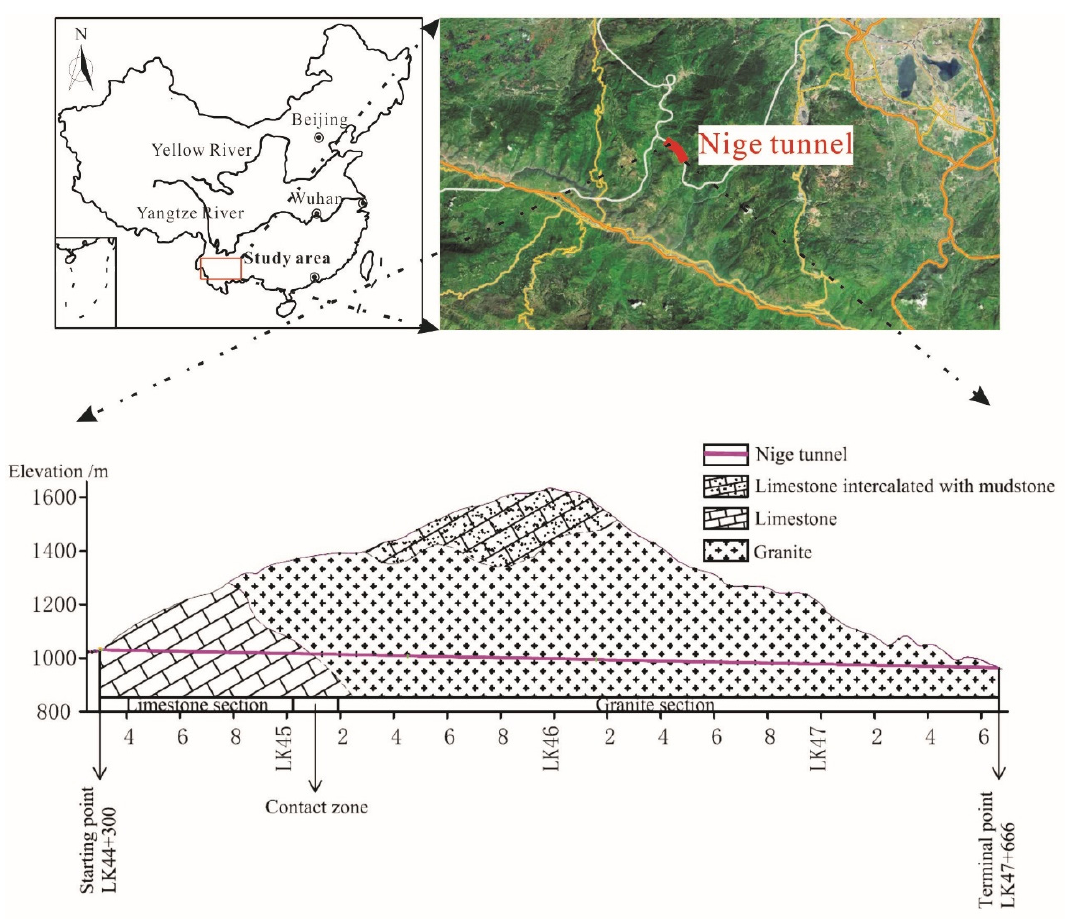
Figure 1. Geographical location and cross section of the Nige tunnel. The Nige tunnel crosses high and middle mountain terrain, with a distribution eleva- tion of 959 m to 1641.6 m, and the relative height difference is 682.6 m. The topographic slope at the tunnel entrance section is relatively steep, with a slope of 30 ◦ to 35 ◦ . The slope near the tunnel is distributed with Quaternary loose eluvial diluvium, on which the vegetation, mainly shrubs, is well developed, and the bedrock is locally outcropped. The topographic slope at the tunnel exit section is 20 ◦ to 25 ◦ . Simultaneously, the slope is also distributed with Quaternary loose eluvial diluvium, and the vegetation on it is densely developed. From the high elevation to the low elevation in Figure 1, the strata in the Nige tunnel site are Quaternary eluvial diluvium and Yanshanian granite, which is the lower member of the Gejiu formation of the Middle Triassic system. The lithology is a light gray thin layer and a medium-thick layer of dolomite and limestone. Since the Paleozoic, the tunnel site has experienced many tectonic disturbances, so a complex geological structure occurs in the